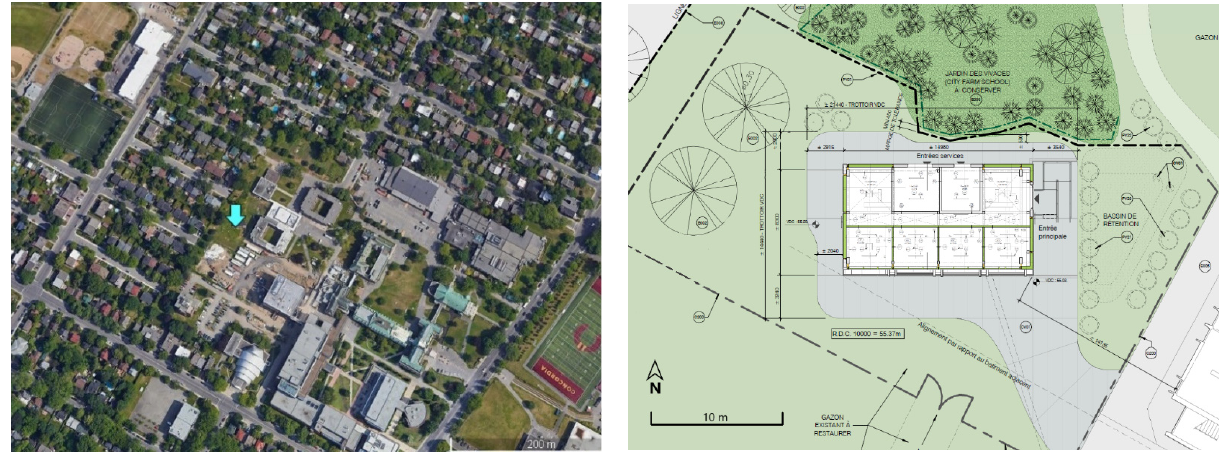
Figure 1. Situation/location plan, and landscape boundaries/floor plan.